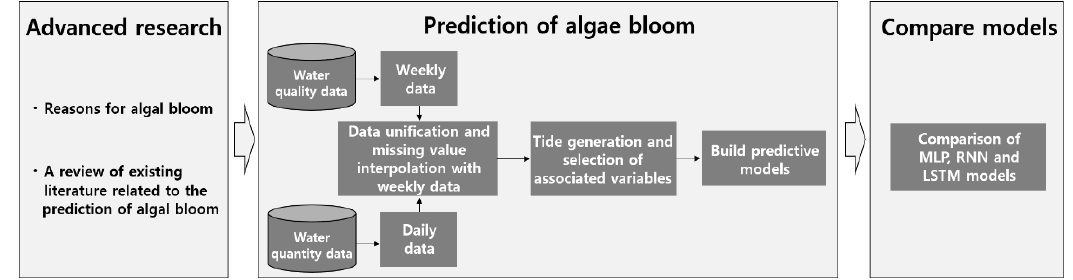
Figure 1. Research framework showing the three stages used to compare deep learning models.